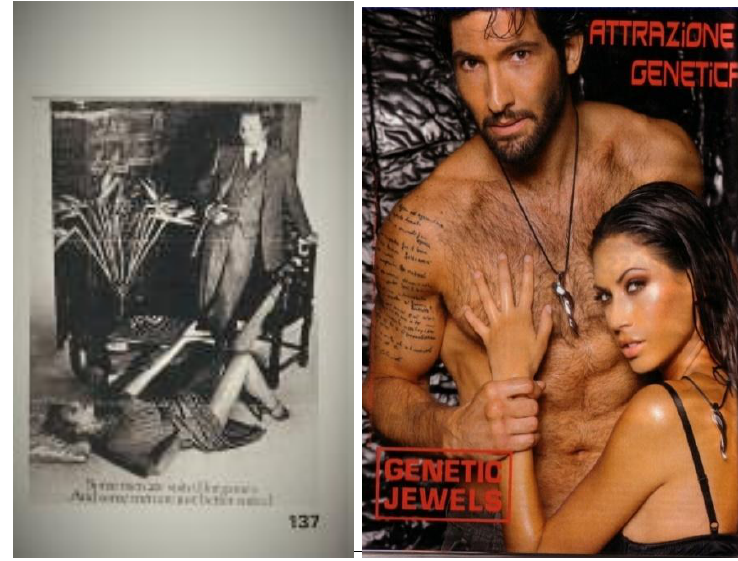
Figure 5. Goffman’s picture and selected picture, Physical lowering.